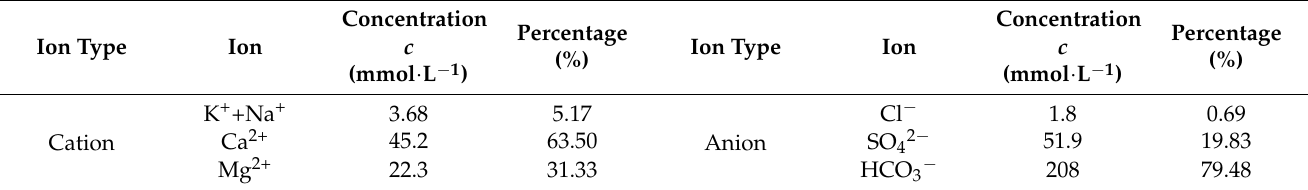
Table 2. Concentration of main ions in tunnel drains.